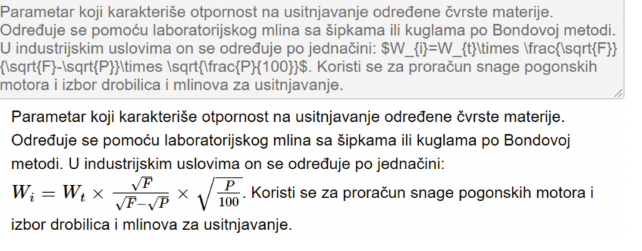
Figure 6. Formula editing and preview in term entry.